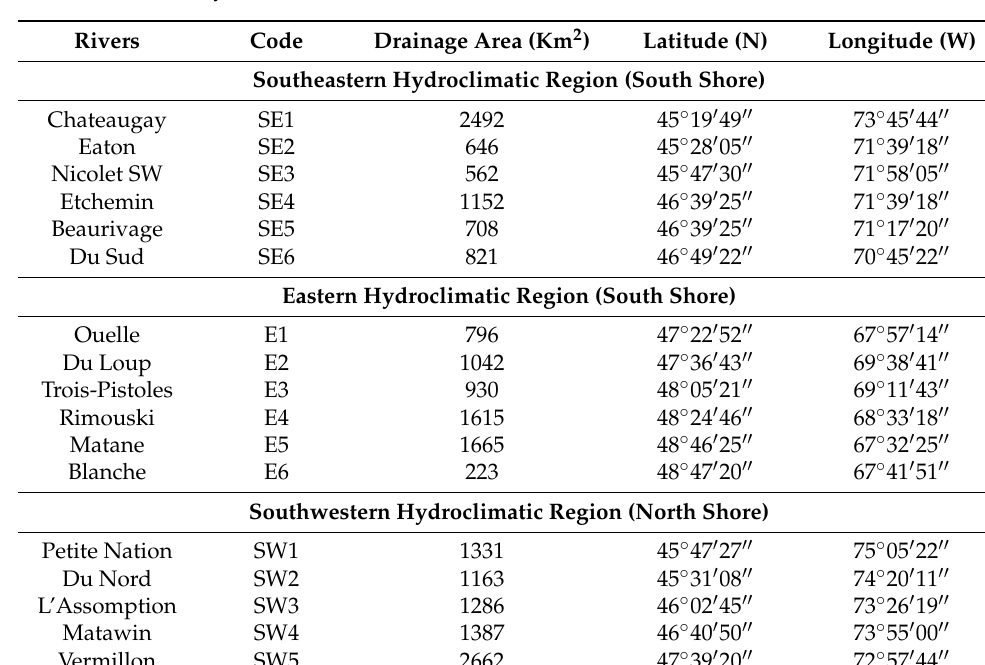
Figure 1. Location of stations. SE = Southeastern Hydroclimatic Region; E = Eastern Hydroclimatic Region; SW = Southwestern Hydroclimatic Region. Table 1. Rivers analyzed.